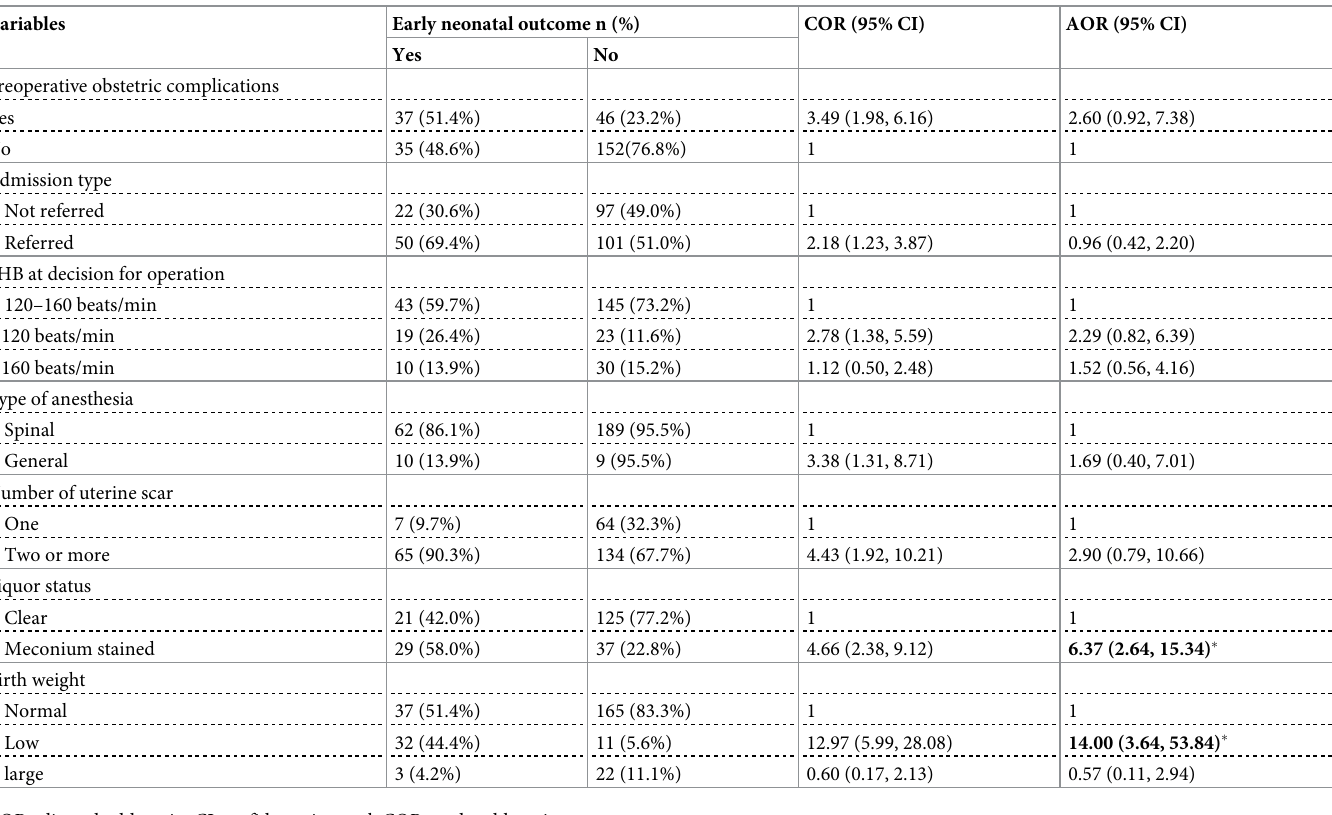
Table 5. Binary and multivariable logistic regression analyses of factors affecting early neonatal outcomes in HUCSH, Southern Ethiopia, Oct 2018.